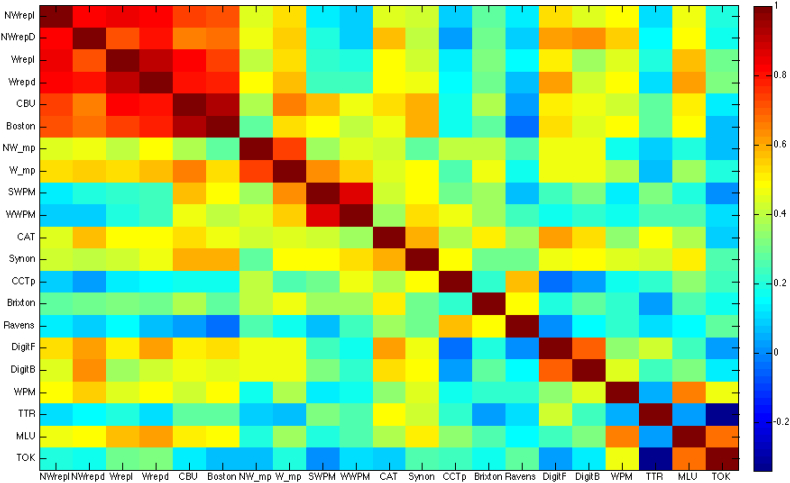
Covariance matrix of raw data converted into z-scores (therefore matrix scale is 0–1).